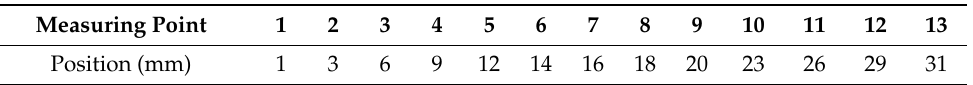
Table 3. Distance of measuring points from origin (point O ).